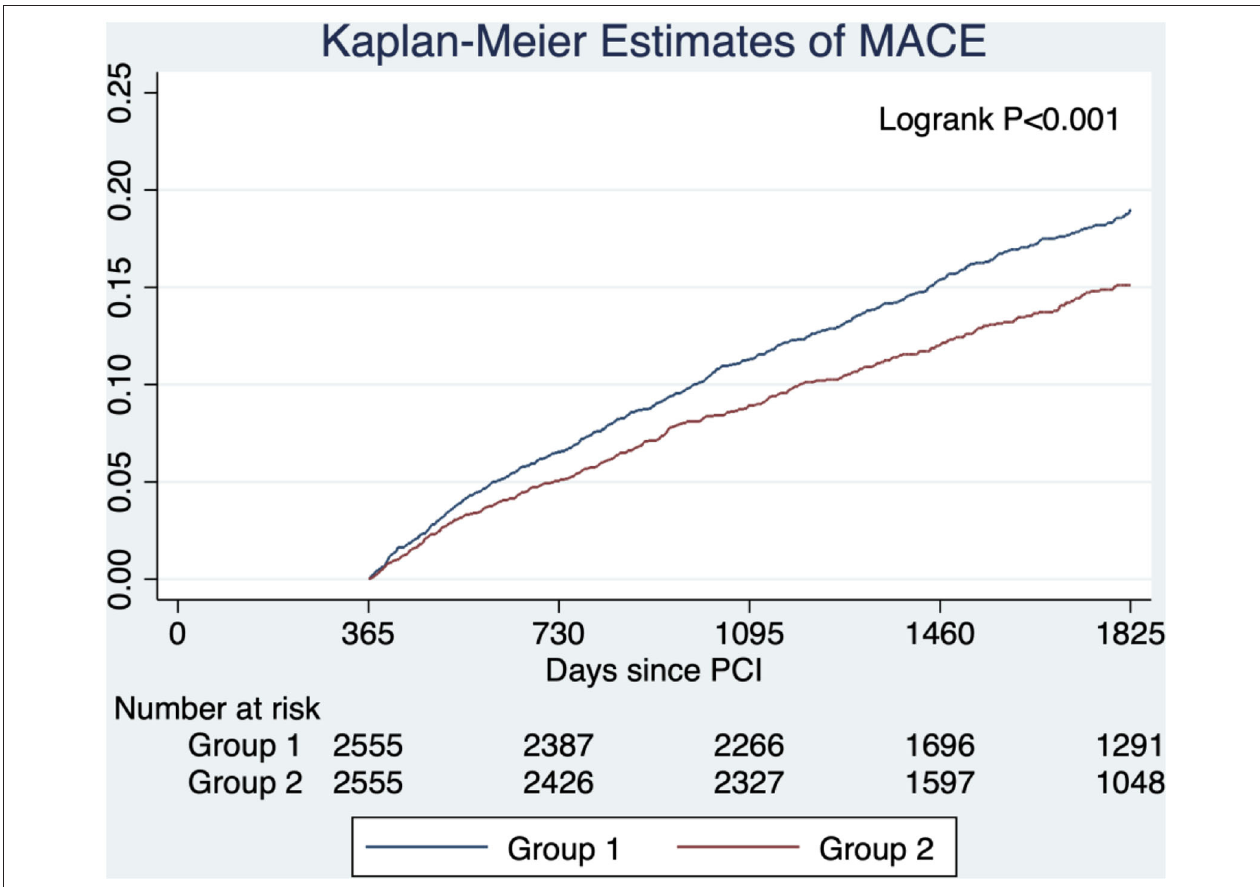
FIGURE 3 | Estimated probabilities of major adverse cardiovascular events stratified by lipid management strategy after propensity score matching. Group 1 (target criteria only) had a higher risk of MACE compared with group 2 (intensity criteria only) in the propensity score-matched cohort.